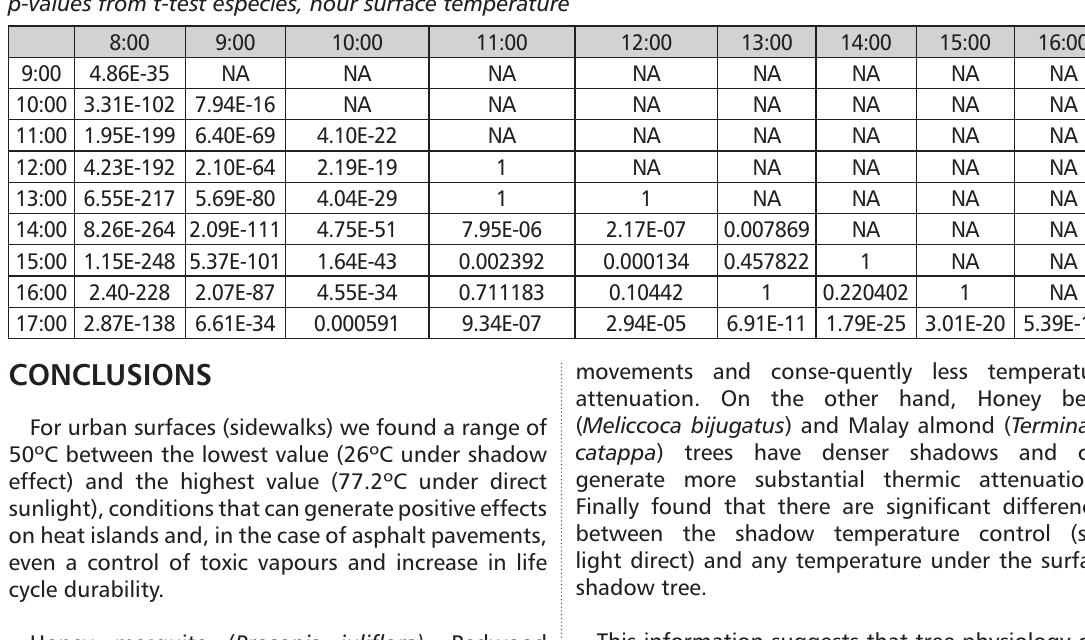
TABLE 6 p-values from t-test especies, hour surface temperature